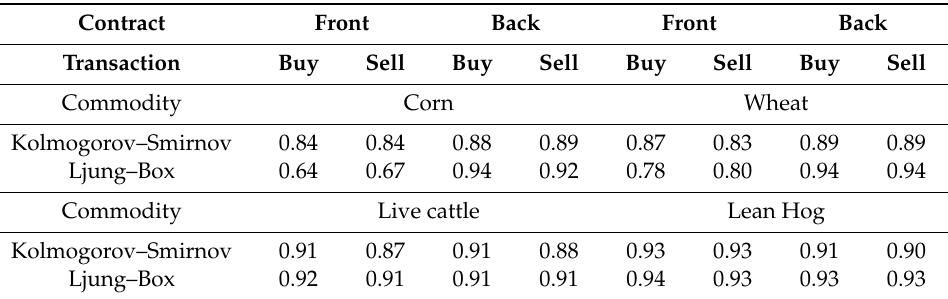
Table 3. Residual